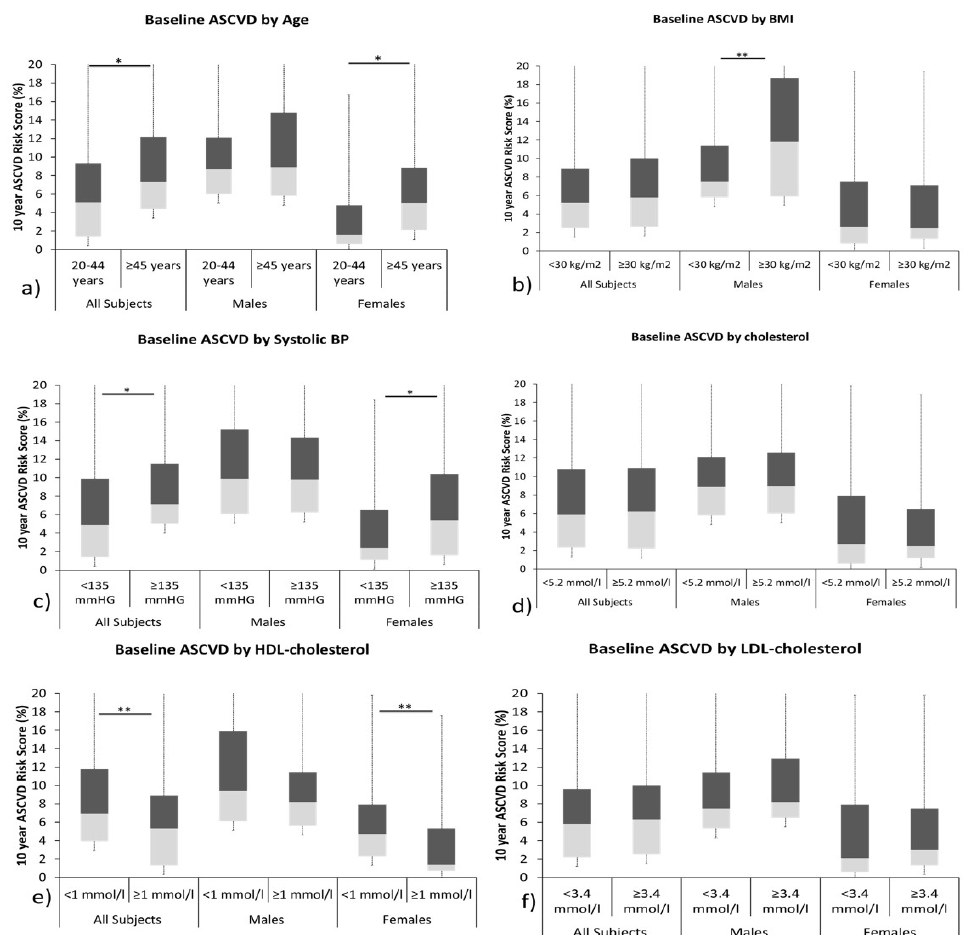
Figure 1. Box-plot representing ASCVD risk scores in study participants at recruitment, stratified according to ( a ) age, ( b ) BMI, ( c ) systolic blood pressure, ( d ) cholesterol levels, ( e ) HDL cholesterol, and ( f ) LDL cholesterol. * and ** statistical significance at p < 0.05 and p < 0.01 levels, respectively.